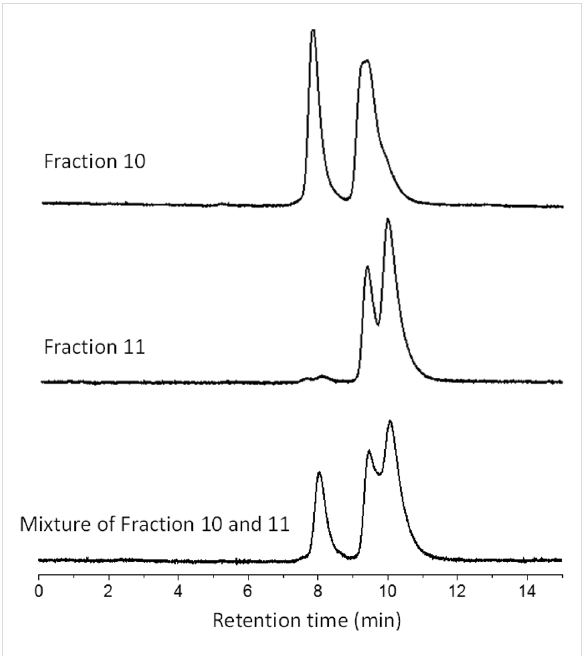
Figure 5: The retention time of the first species in fraction 10 is shorter than the species in fraction 11 on silica gel HPLC column (cyclo- hexane, 1.0 mL/min) providing information on the relative polarity of the compounds under